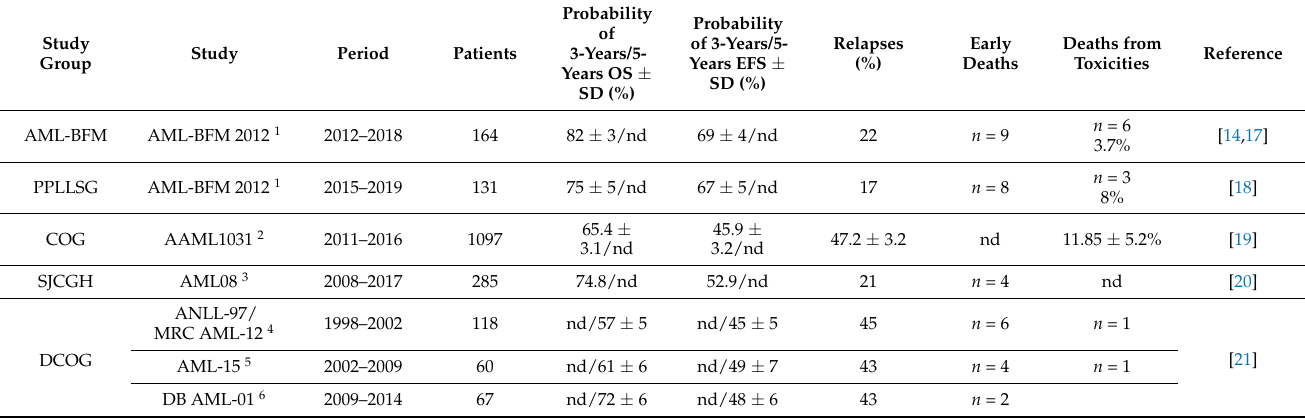
Table 2. Pediatric AML treatment outcomes based on therapeutic